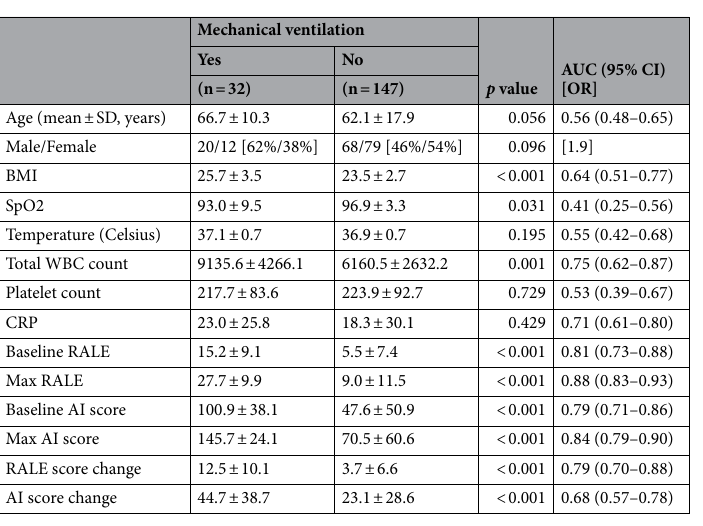
Table 4. Summary of assessed variables for predicting need for mechanical ventilation in patients from Site B. Maximum RALE and AI scores were the strongest predictors of need for mechanical ventilation. SD standard deviation, BMI body mass index, SpO 2 peripheral oxygen saturation, CRP c-reactive protein, max maximum, AUC area under the curve, CI confidence interval, OR odd’s ratio, % percentage. Numbers in square parenthesis represent odd’s ratios (R2-14).